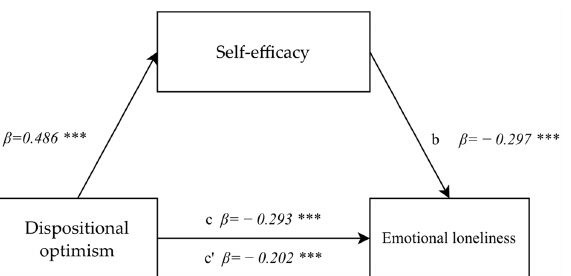
Figure 4. The model of a mediatory role of self-efficacy between dispositional optimism and emotional loneliness. Explanation: Statistically significant: *** p < 0.001.